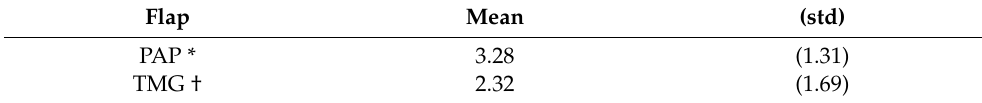
Table 4. Thigh circumference difference (cm) in patients with unilateral flap